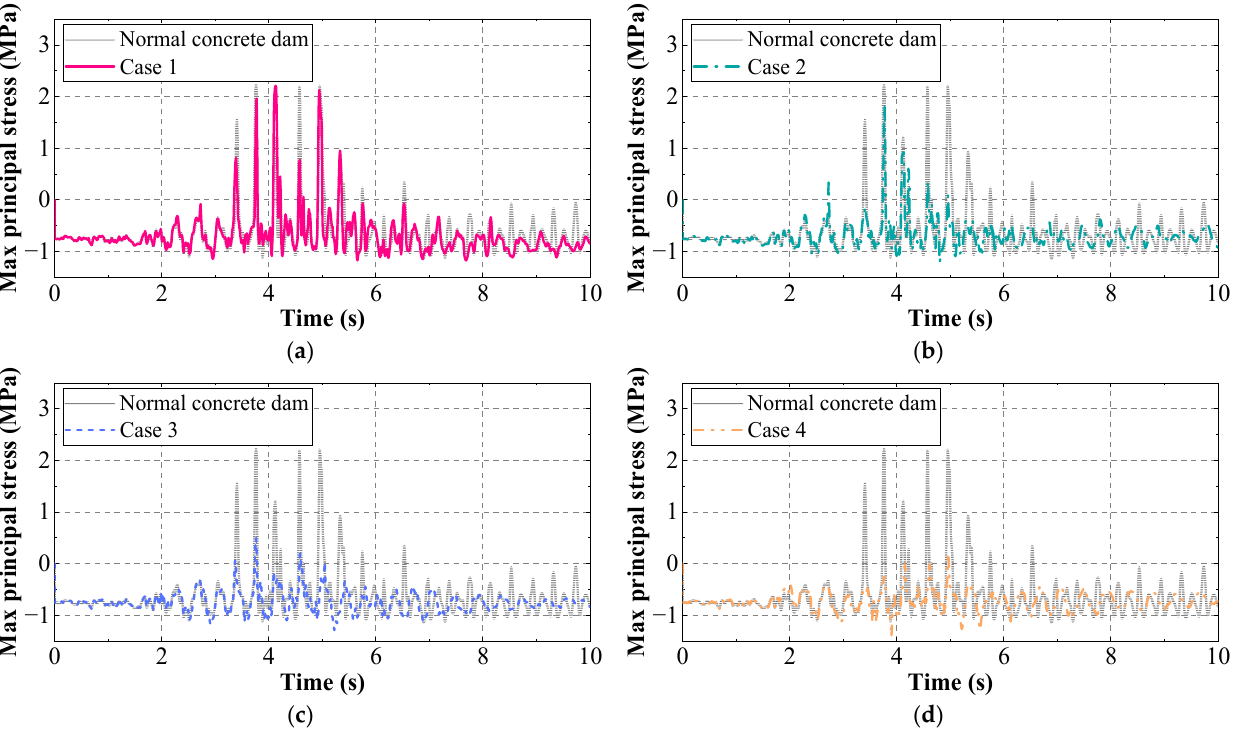
Figure 13. Maximum principal stress responses of the dam heel. ( a ) Case 1; ( b ) Case 2; ( c ) Case 3; ( d ) Case 4.